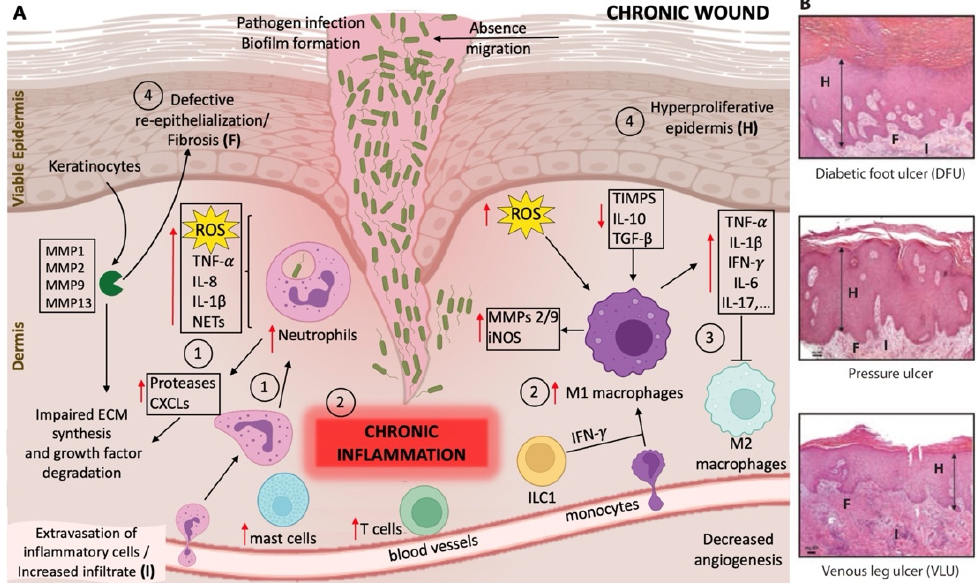
Figure 2. Schematic representation of the molecular pathways and cellular targets involved in impaired wound healing. ( A ) Normal wound healing consists of four phases: (1) homeostasis, (2) inflammation, (3) proliferation, and (4) the tissue remodeling phase (see text). In chronic wounds, the normal wound healing phases are disturbed due to persistent inflammation, which ultimately results in an imbalance and dysregulation of skin immune function, as well as the presence of infection with biofilm formation. The dysregulation of skin immune function leads to an excessive neutrophil and macrophage infiltration, together with an uncontrolled release of pro-inflammatory mediators such as interleukins (IL), chemokines, reactive oxygen species (ROS), neutrophil extracellular traps (NETs), and proteases that interfere with essential repair mechanisms. This results in unresolved inflammation, tissue destruction, and ineffective decontamination of pathogenic bacteria. In particular, phases (3) and (4) of normal wound healing are impaired, leading to the absence of macrophage phenotype conversion from the pro-inflammatory M1 to the anti-inflammatory M2 phenotype, and subsequently to reduced angiogenesis, impaired extracellular matrix (ECM) synthesis, absence of keratinocyte migration, and a hyperproliferative epidermis. Red arrows indicate the increase ↑ or decrease ↓ of the molecular/cellular targets in chronic wounds. MMPs, matrix metalloproteinases; CXCLs, C-X-C motif ligand chemokines; ILC1, innate lymphoid cells group 1; IFN- γ , interferon gamma; iNOS, inducible nitric oxide synthase; TIMPs, tissue inhibitor of metalloproteinases; TGF- β , transforming growth factor beta; TNF- α , tumor necrosis factor alpha. ( B ) Histologic images (H/E stain) showing the characteristics of chronic wounds in examples from diabetic foot ulcer (DFU), pressure ulcer, and venous leg ulcer (VLU) tissue. The most common cellular characteristics are depicted: H, hyperproliferative epidermis; F, defective re-epithelization/fibrosis; I, extravasation of inflammatory cells/increased infiltrate (inflammation). The images in ( B ) are reproduced from [16]. Reprinted with permission from AAAS, 2014.